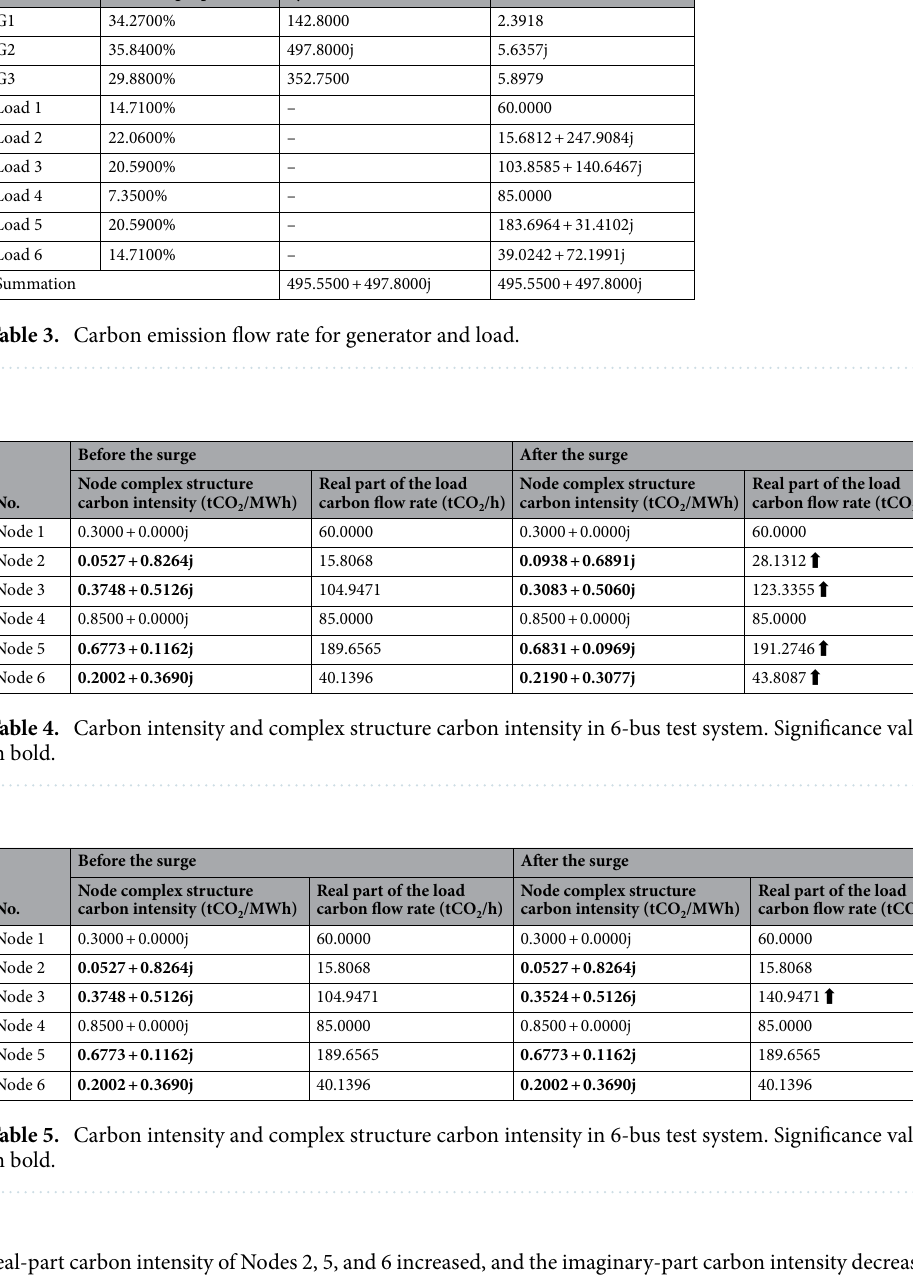
Table 5. Carbon intensity and complex structure carbon intensity in 6-bus test system. Significance values are in bold.